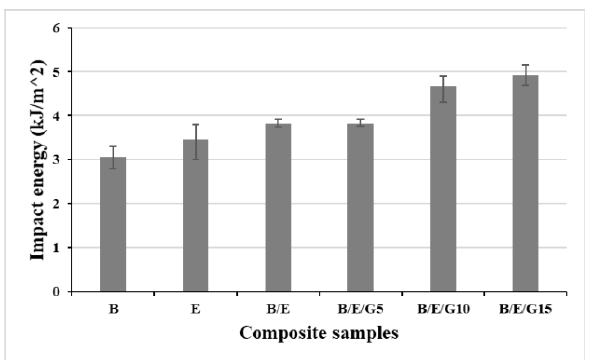
Figure 8. Impact energy of basalt and E-glass composite samples.